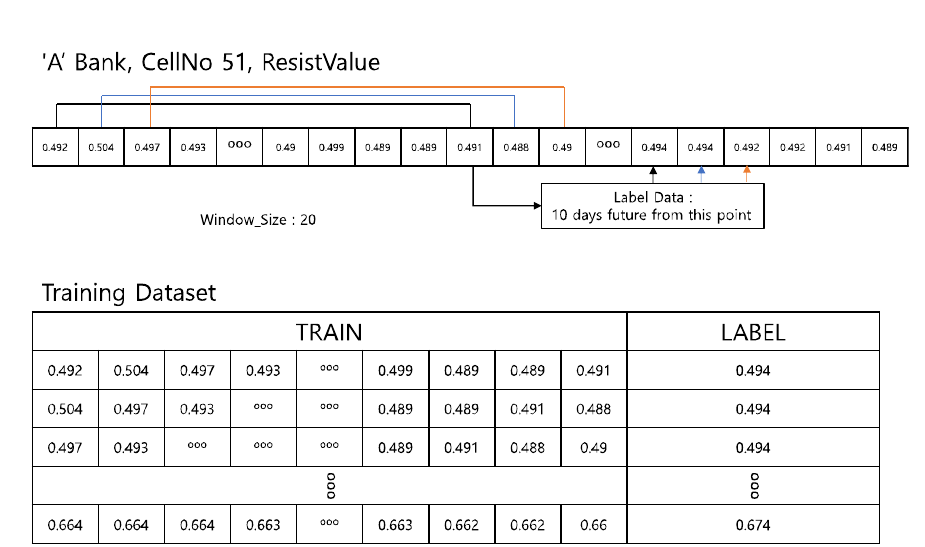
Figure 7. Training dataset.